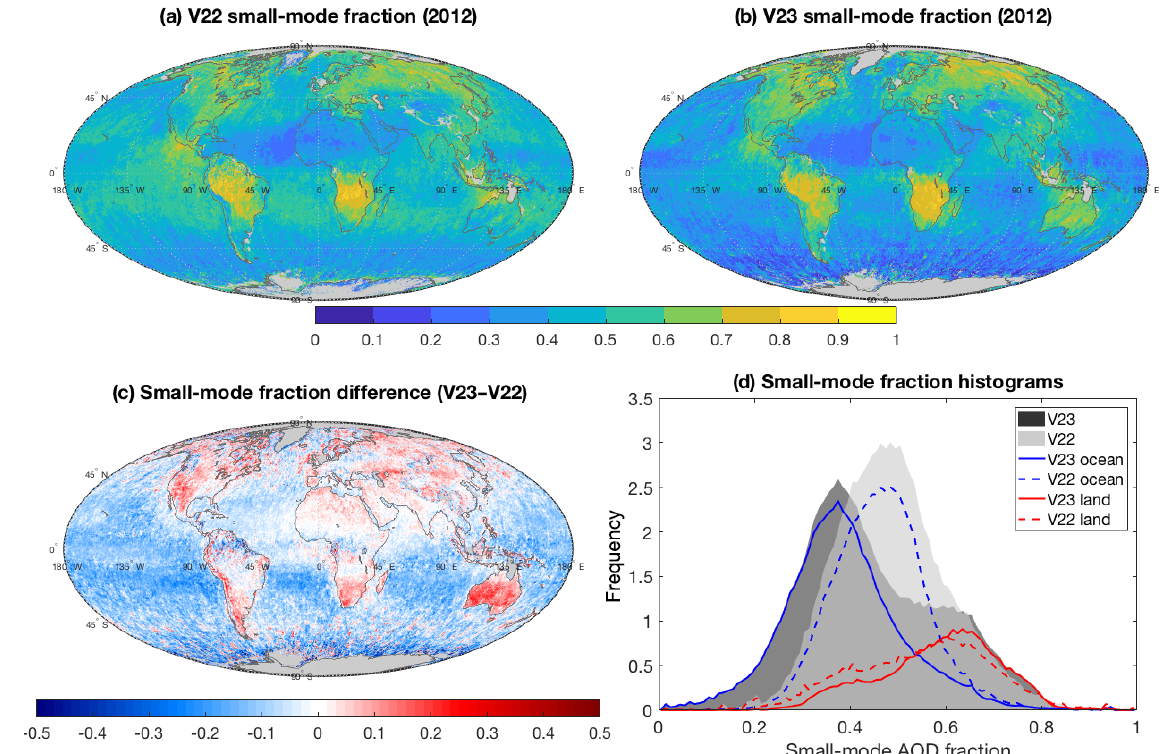
Figure 12. As in Fig. 7 except for the MISR-retrieved small-mode AOD fraction. AOD weighting is applied in data